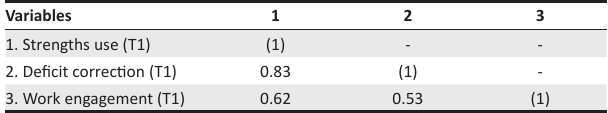
TABLE 5: Correlation matrix for the latent variables at time 2.